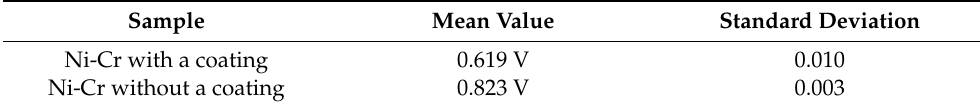
( b ) Figure 6. Image of the pits after corrosion tests, ( a ) sample without a coating, ( b ) sample with a coating. After the corrosion examinations, corrosion pits appeared on the surface of the sam- ples, 50–100 μ m in size. An effect of the intensive corrosive processes is also removal of the carbon layer from the area near the formed pit, which is visible in Figure 6b.